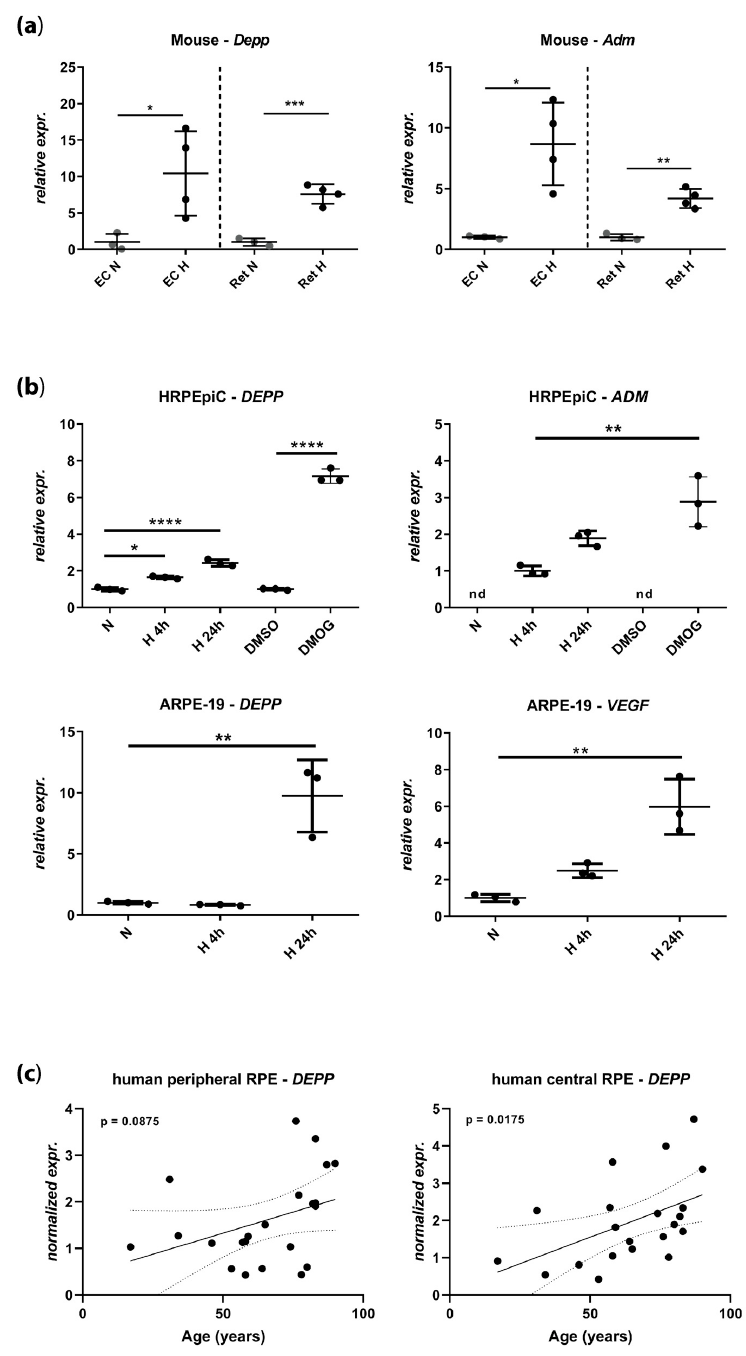
Figure 1. Expression levels of decidual protein induced by progesterone ( DEPP ) and known hypoxia- inducible factors (HIF) target genes by semi-quantitative real-time PCR in ( a ) mouse eyecups (EC) and retina (normoxia: N = 3 eyes of three mice; hypoxia: N = 4 eyes of three mice) and ( b ) human retinal pigment epithelial cells (HRPEpiC) and human RPE cell line ARPE-19 cells. Levels in